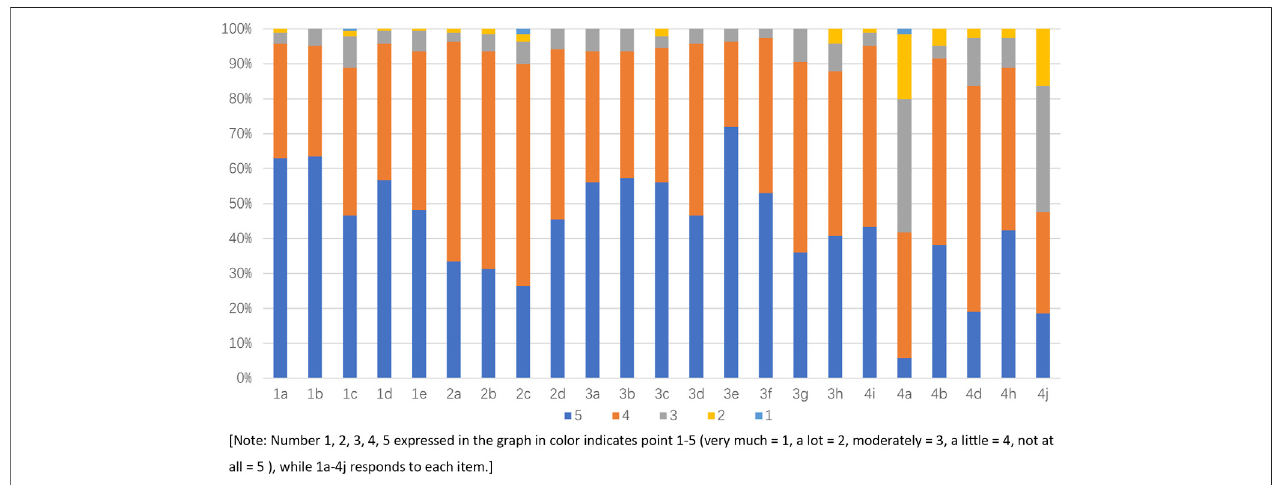
FIGURE 1 | Response to each item of the Chinese version of the